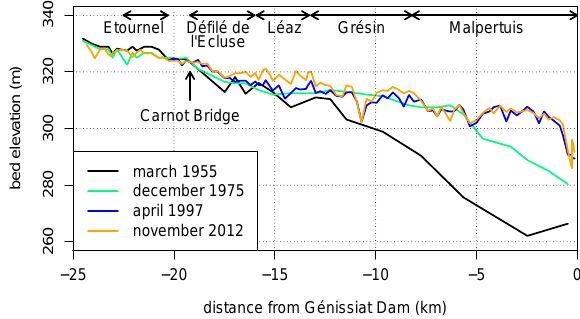
Fig. 2. Evolution of the Longitudinal profile of the Génissiat reser-